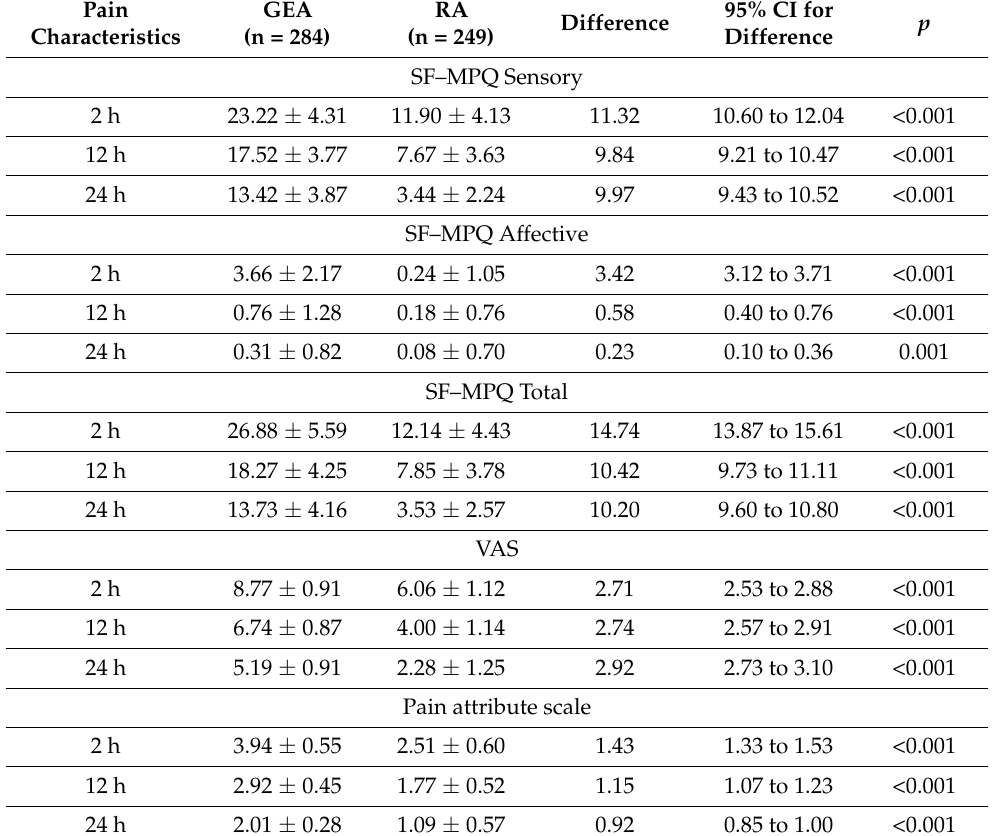
Table 1. Pain characteristics after cesarean section according to anesthesia type. Pain